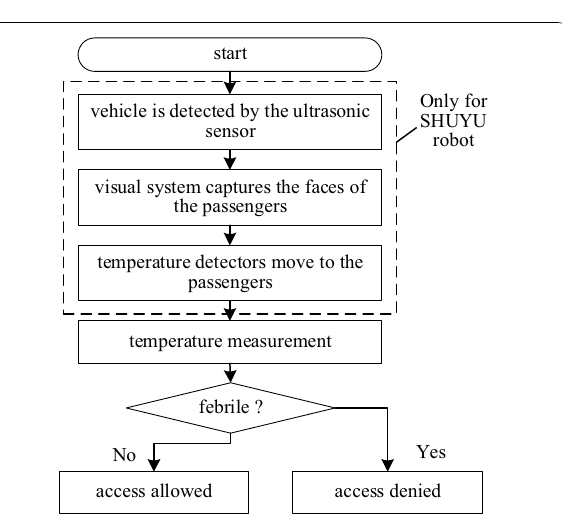
Figure 6 Flow chart of the screening